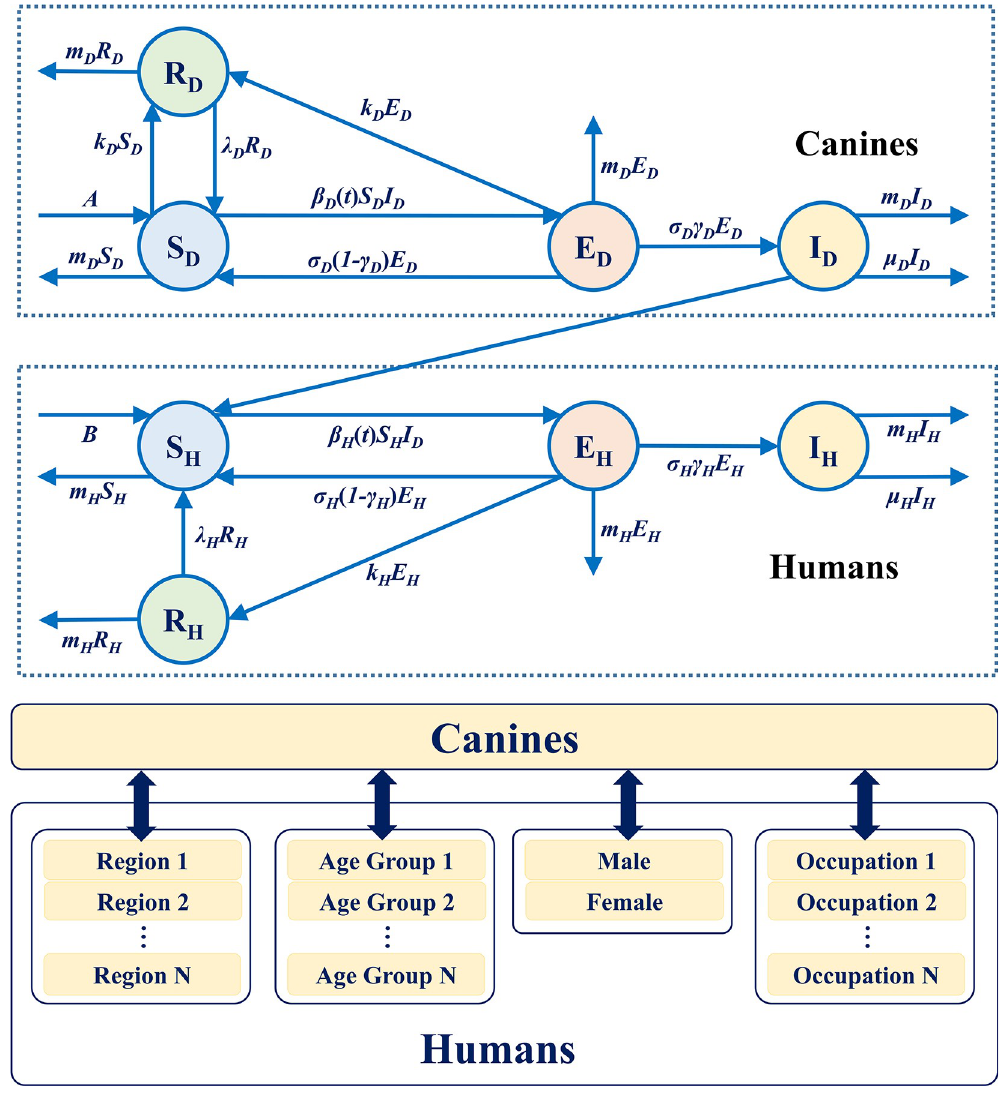
Fig 1. Transmission model of rabies among canines and from canines to various human